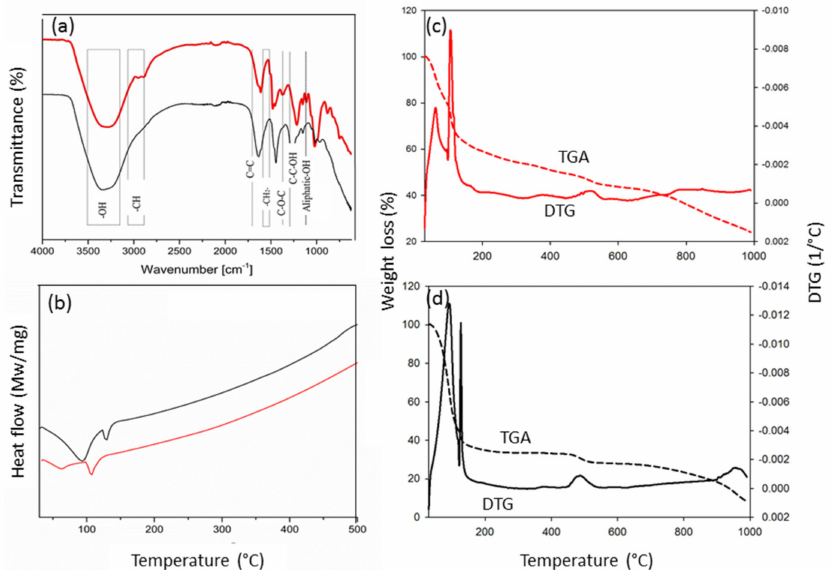
Figure 1. Analysis of commercial ( − ) and synthesized ( − ) phenolic resin (PF). ( a ) Fourier transform infrared (FTIR) spectrum shows that functional groups present in commercial PF were also found in synthesized PF, ( b ) the T g of synthesized PF (106 ◦ C) was lower than commercial PF (119 ◦ C), ( c ) thermogravimetric analysis (TGA) and derivatives thermogravimetry (DTG) curves of synthesized PF, and ( d ) TGA and DTG curves of commercial